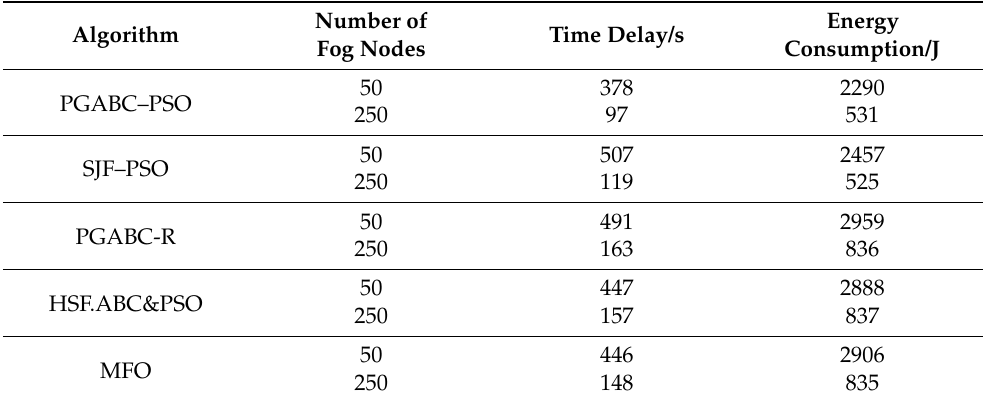
Table 5. The delay and energy consumption calculated using the five strategies when the number of fog nodes was 50 and 250.